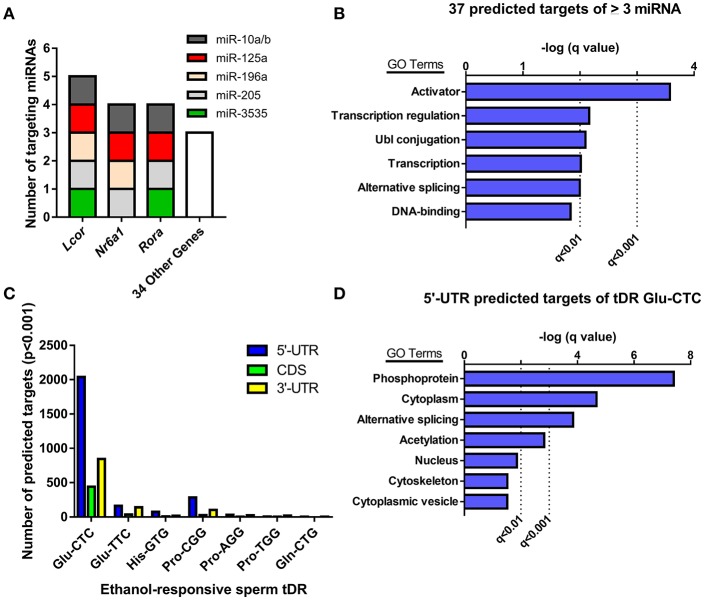
Analyzing predicted gene targets of ethanol-responsive sperm miRNA and tDR Glu-CTC. (A) Genes with 3′-UTRs targeted by three or more miRNAs. (B) Gene ontology analysis of predicted target genes of ≥ 3 miRNA. (C) Number of genes with predicted 5′-UTR, coding, or 3′-UTR targets of ethanol-responsive sperm tDR. (D) Gene ontology analysis for genes with predicted 5′-UTR targets of tDR Glu-CTC.